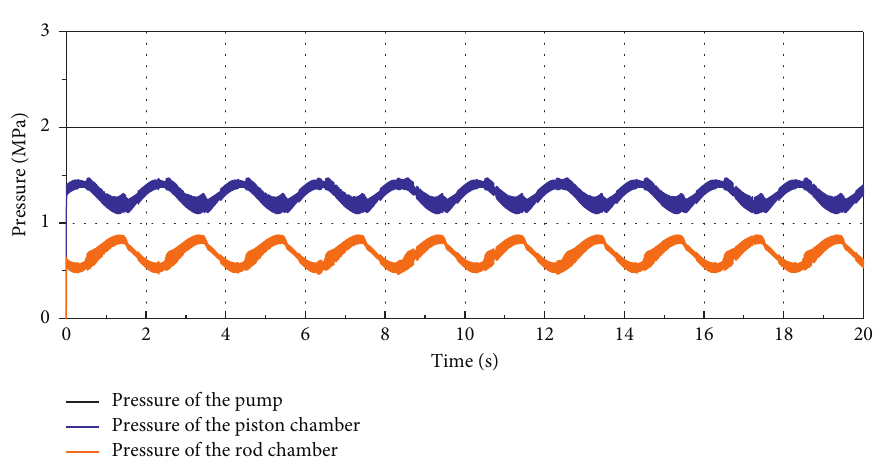
Figure 9: Pressures of system 1.